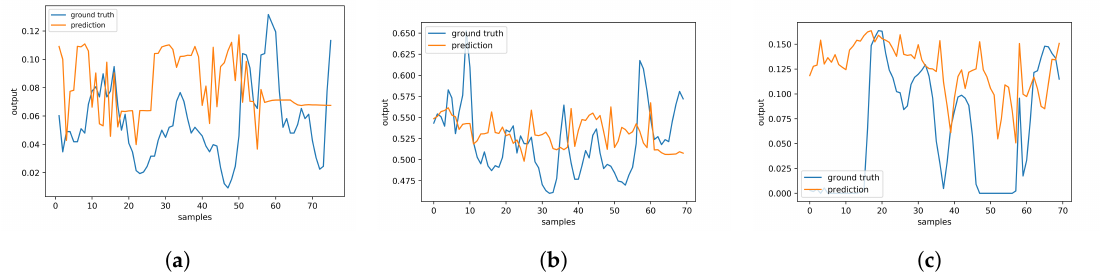
Figure 9. Prediction and ground truth outputs over 70 test samples. ( a ) PM2.5 in Beijing PM2.5 dataset; ( b ) PT08.S1(CO) in Italy Air Quality dataset; ( c ) O3 in Beijing Multi-Site